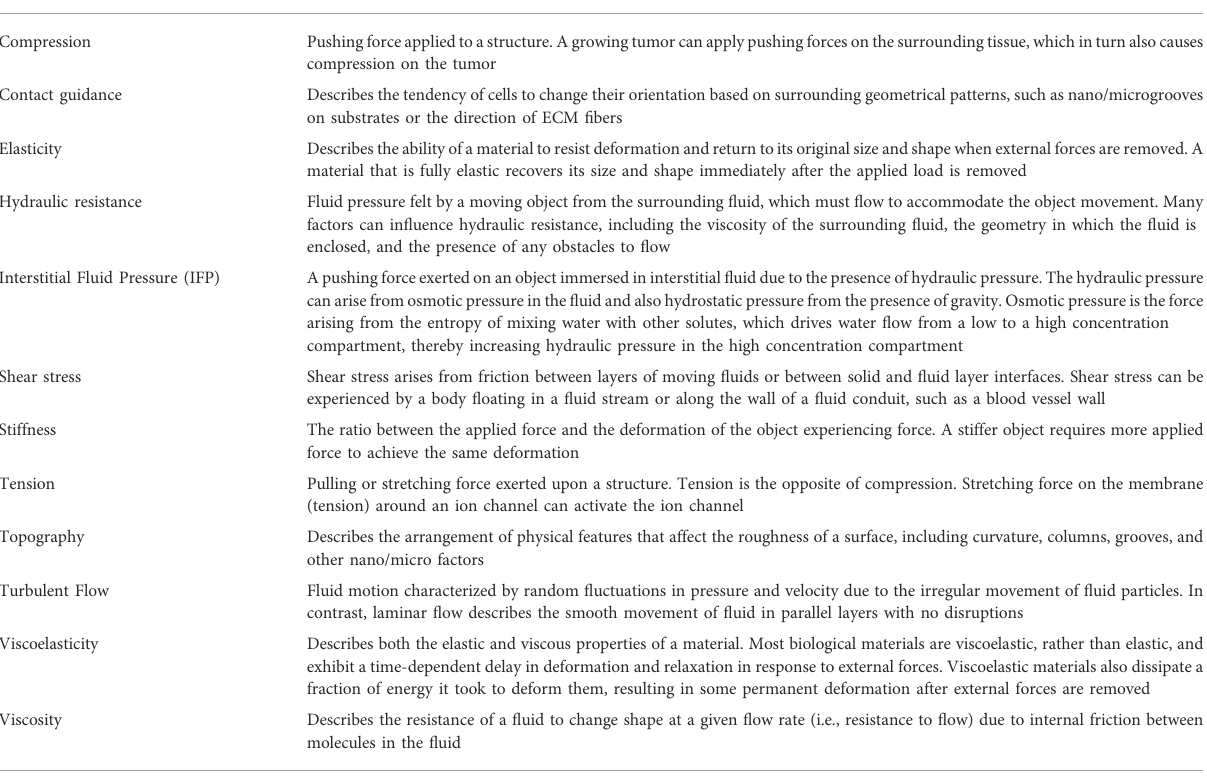
TABLE 1 Physical cues encountered by cancer cells during the metastatic